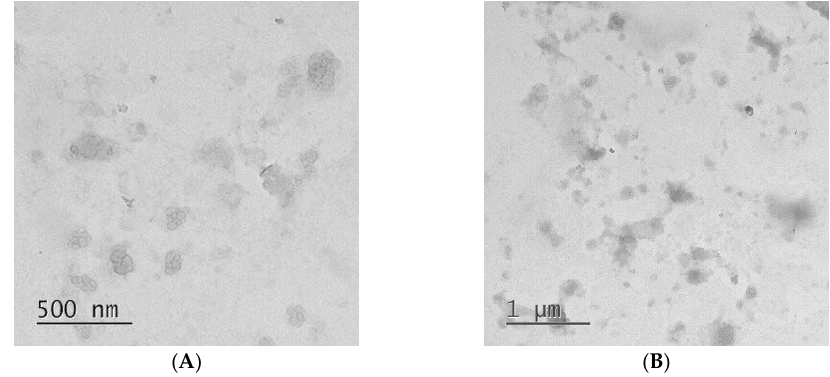
Figure 2. Images of PLL-Hep IPECs (ratio [NH 3+ ]:[SO 3 − ] = 1:3 moL/moL]) obtained by transmission electron microscopy: ( A )—500 nm scale; ( B )—1000 nm scale. electron microscopy: ( A )—500 nm scale; ( B )—1000 nm scale.